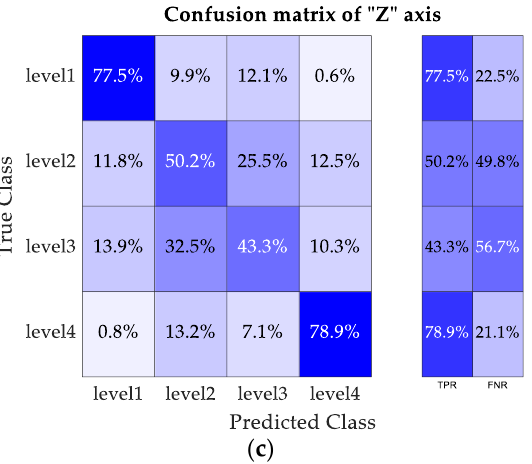
Figure 13. ( a ), ( b ), ( c ) confusion matrix with true positive rate data (TPR) and false negative rate (FNR) ( b ) confusion matrix with positive predictive values (PPV) and false discovery rate (FDR).